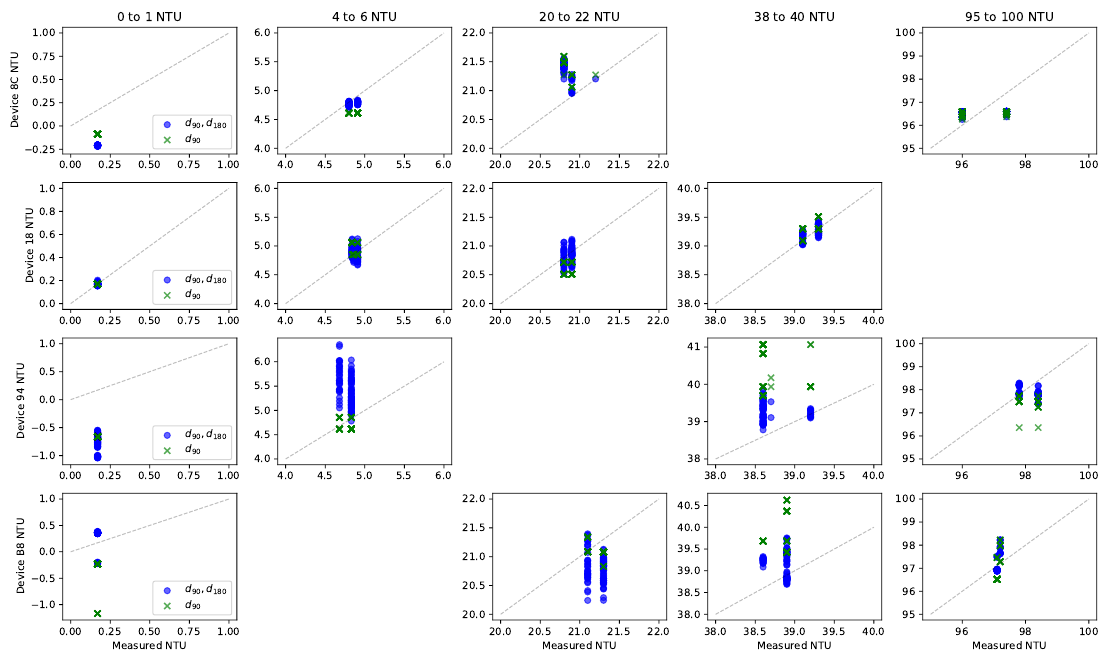
Figure 10. Predicted NTU vs. measured NTU for the individual models on the 5 tested NTU ranges.